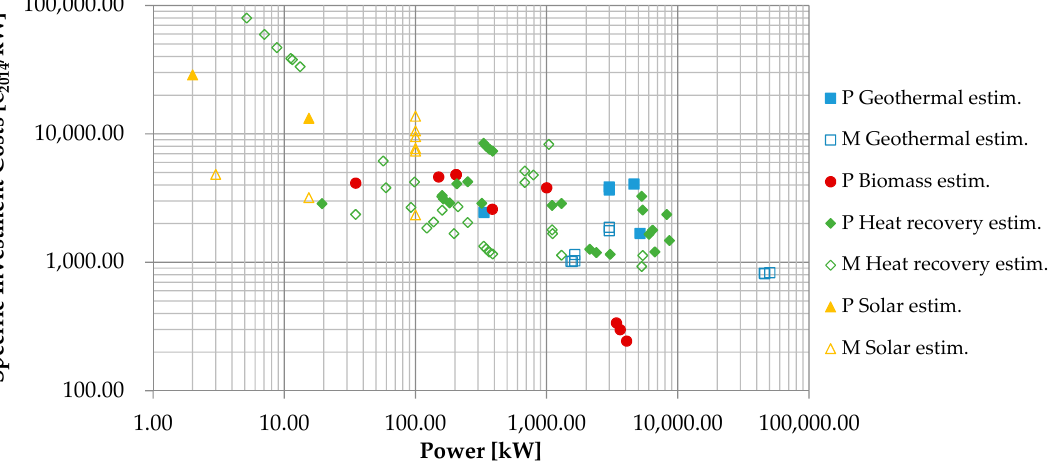
Figure 1. Estimated costs of ORC Projects (P) and Modules (M) in literature, in 2014 Euros. Sources: [23,32,33,35,38–40,46–70].